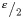
Latent mixture model of choice probability.In the present study, choice probabilities were assumed to be a latent mixture of erroneous button presses (with probability ε) and accurate button presses (with probability 1−ε). Since erroneous button presses are by definition undirected, these choices are therefore equally likely to result in the selection of the informative signal or the non-informative signal. This has the effect of placing a floor of ε2 and a ceiling of 1−ε2 on choice probabilities for each option.